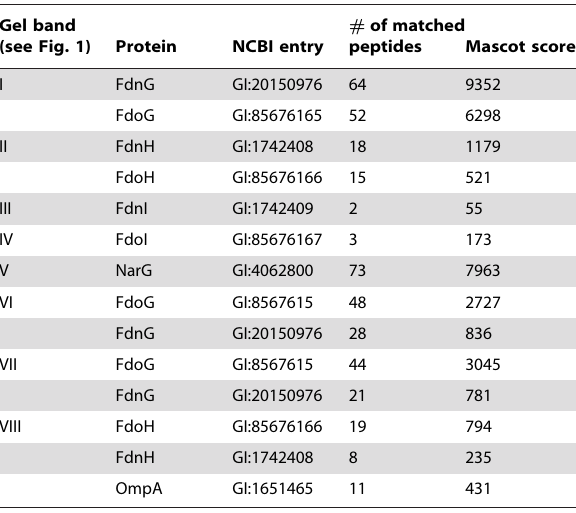
Table 1. Proteins obtained in fractions 2, 3, and 5 (see Figs. 1A and B) from anion exchange chromatography that were identified by nano-ESI-LTQ-Orbitrap-MS/MS analysis; NCBI entry numbers are